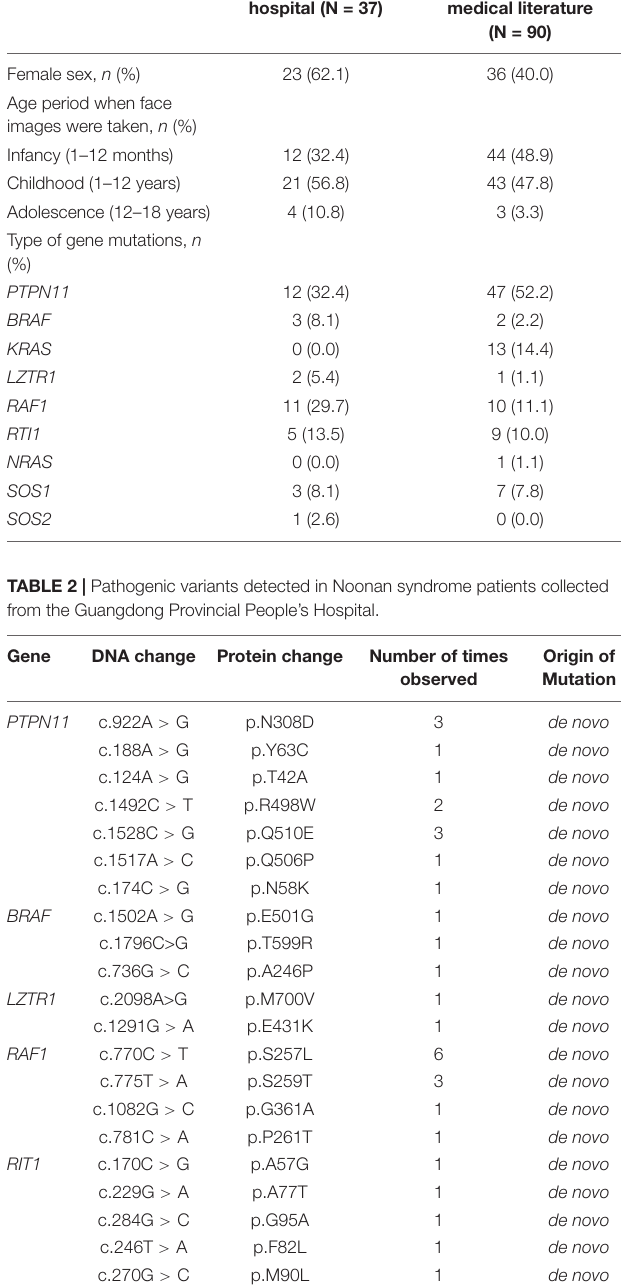
TABLE 1 | Demographic and genetic characteristics of Noonan syndrome patients. Characteristics